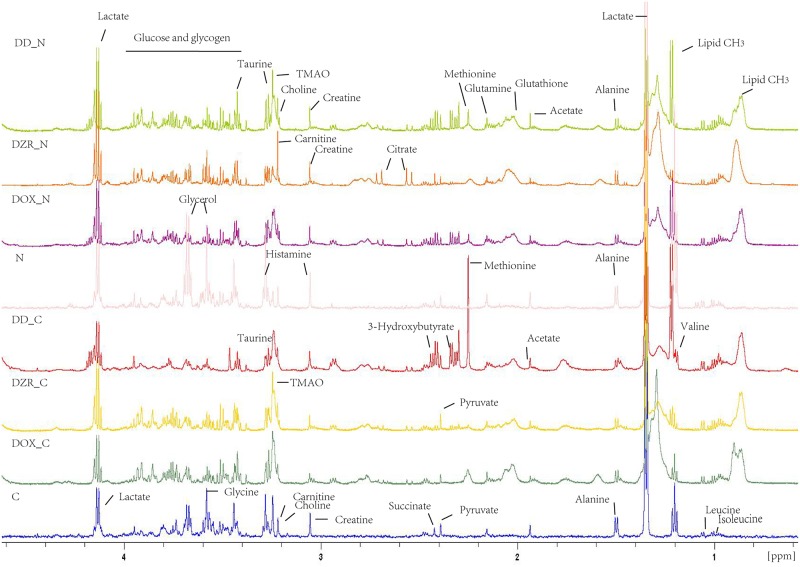
The typical 1H-NMR spectra of the serum from the different treatment models.The metabolites are assigned and marked. The overlapping peaks were identified by adding a reference substance to the sample.